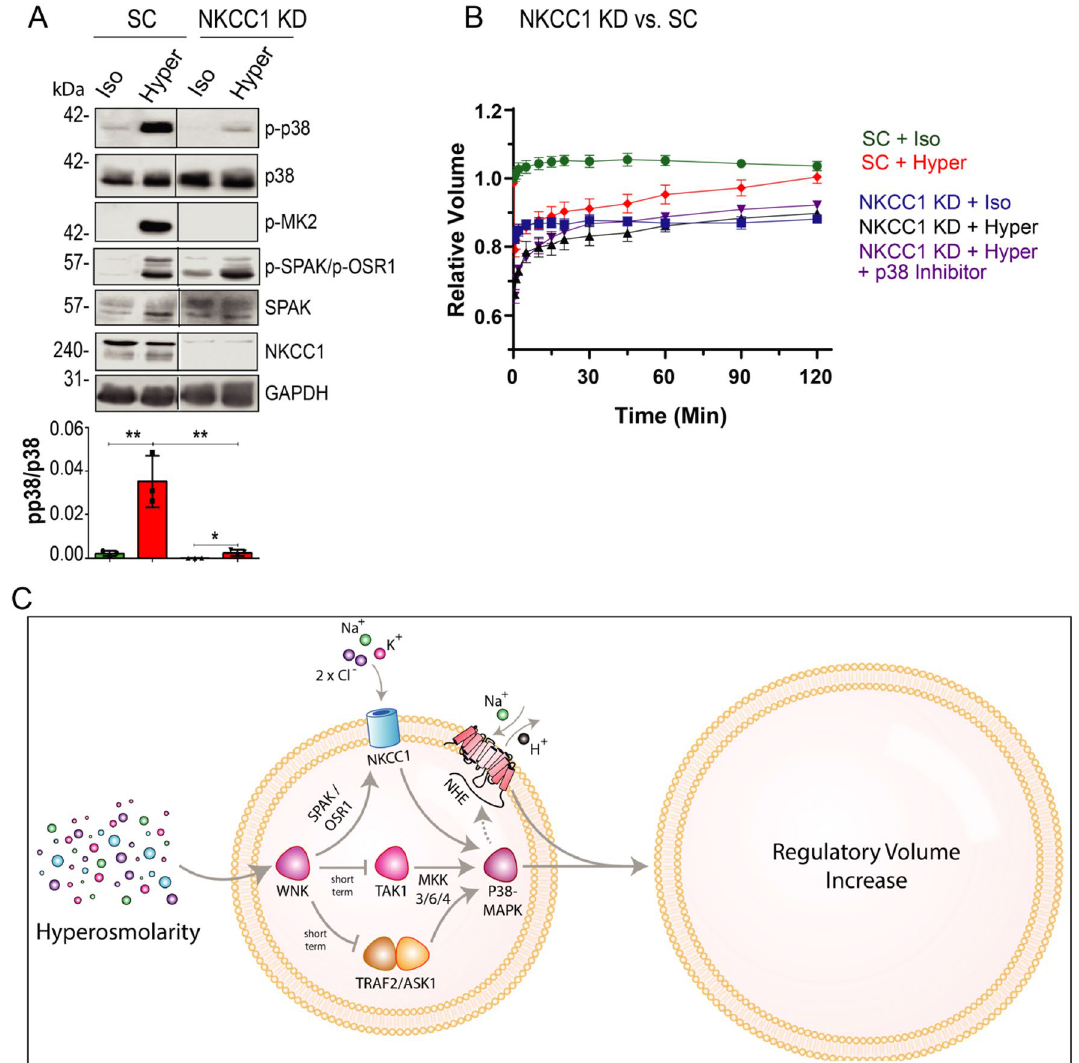
Figure 6. NKCC1 depletion inhibits p38 activation, and summary of pathways that regulate RVI. ( A ) NKCC1 stable knockdown (or scramble control, SC) HeLa cells were treated with iso- or hyper- osmotic NaCl solutions for 15 min. Quantification of active p38 (p-p38) is depicted below their respective blots. Black lines separate the left and right lanes of the same blot. ( B ) Scramble control (SC) or NKCC1 stable knockdown (KD) HeLa cells were treated (or not) with 5 μM SB203580 (p38 inhibitor) for 2 days, washed, exposed to iso- or hyper- osmotic NaCl solution for the indicated times, and RVI measured as described in Fig. 5. All data are mean ± s.e.m, N =